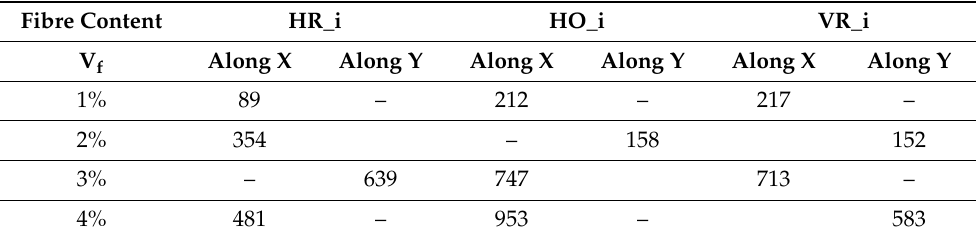
Table 7. Total number of fibres (N f ) counted in a square area of 30 mm in